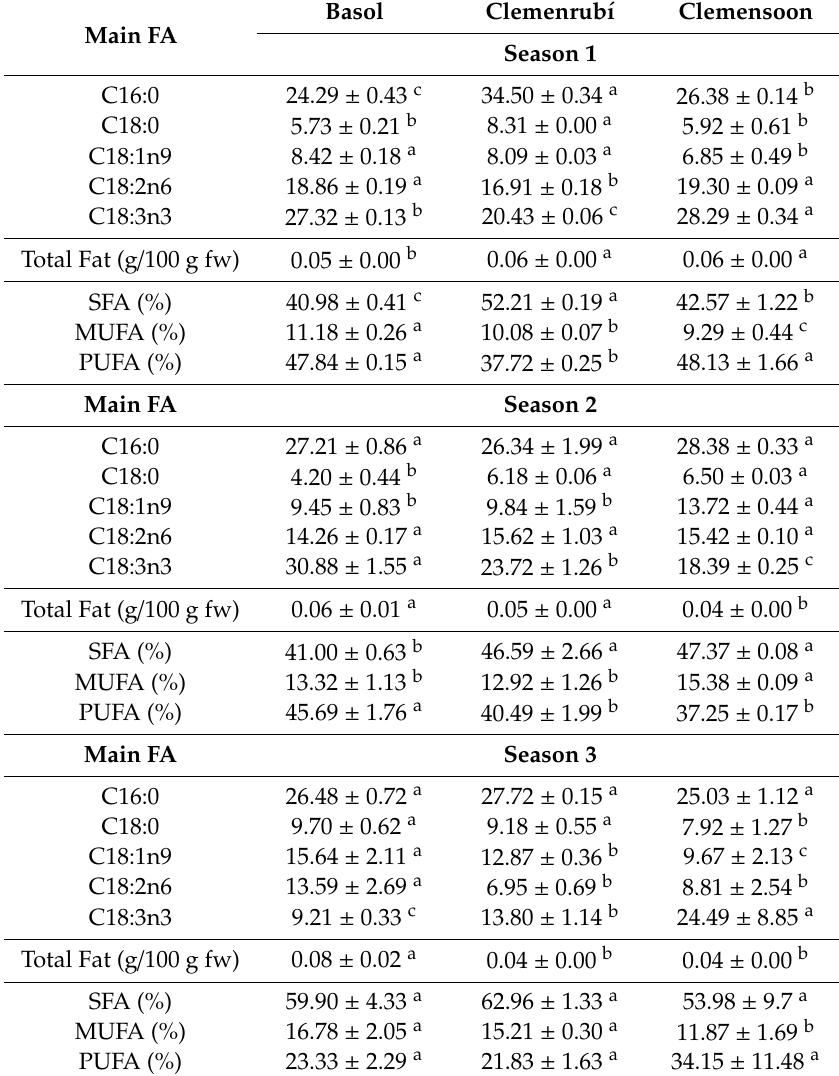
Table 6. Fatty acids (relative %), total fat (g / 100 g fw of fruit edible portion) in extra early clementine varieties (mean ± SD, n =